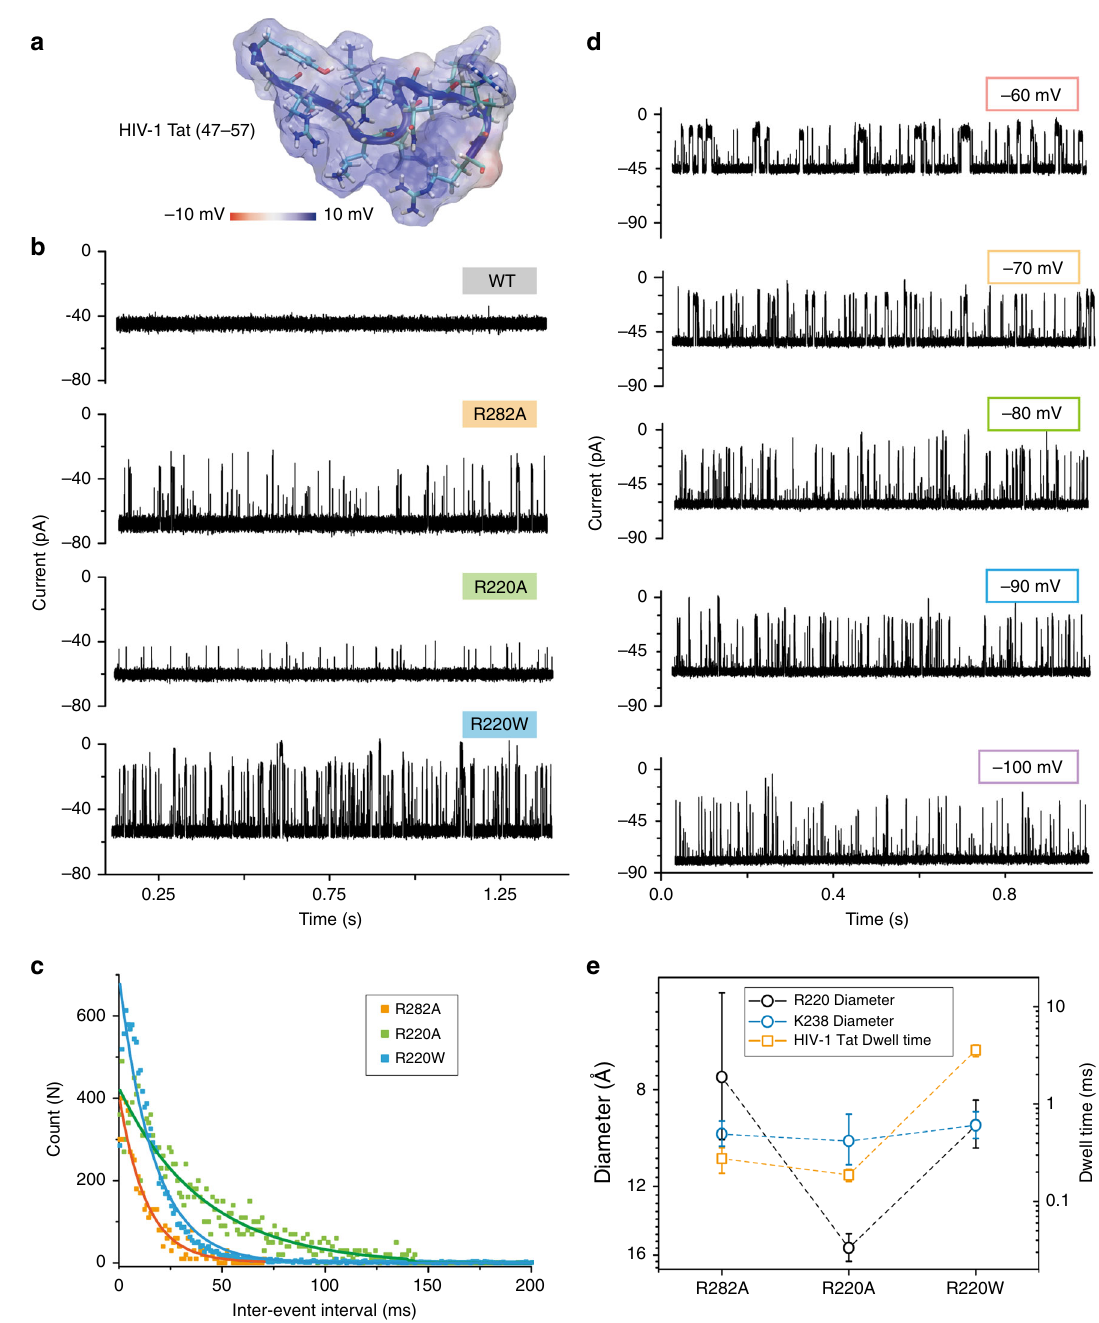
Fig. 5 Positively charged peptide sensing by various engineering pores. a 3D structure of HIV-1 Tat (47 – 57) (PDB:1TAC) with its electrostatic potential mapped on the peptide molecular surface. b Raw single-channel recording traces upon HIV-1 Tat (47 – 57) addition into the cis side of the chamber for wt, R282A, R220A, or R220W, respectively. The fi nal concentration of HIV-1 Tat (47 – 57) in the chamber was 2 μ M. c Inter-event interval ( τ on ) distribution of HIV-1 Tat translocation on the R282A (orange), R220A (green), and R220W (blue) pore mutants. The values were determined by the single exponential fi tting. Relative dwell times are reported in Supplementary Fig. 16. d Raw current traces of HIV-1 Tat (47 – 57) translocation through R220W at different voltages ranging (from − 60 mV to − 100 mV). e Comparison between dwell time of HIV-1 Tat (47 – 57) peptide (orange squares) and the diameter of R220 (black circles) and K238 (blue circles)